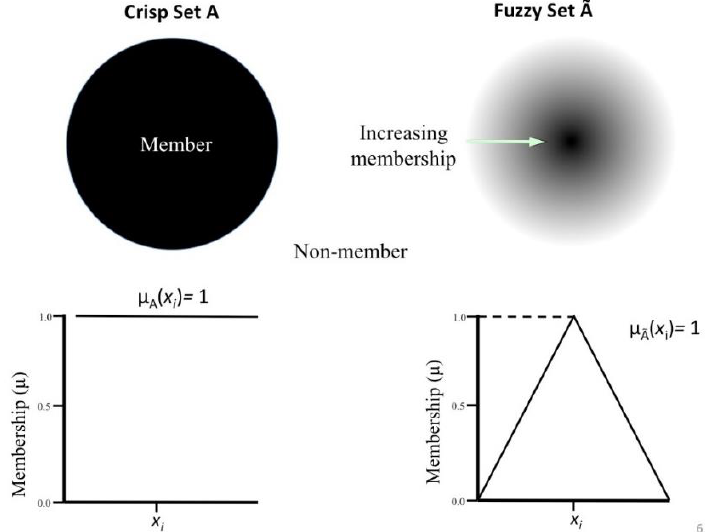
Figure 1. Example of a ( left side ) crisp and ( right side ) fuzzy set, and their respective membership functions.